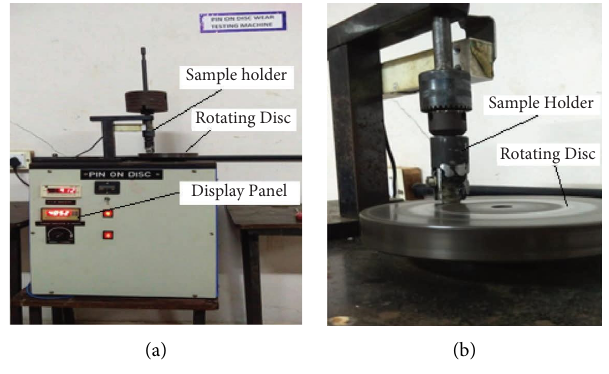
Figure 5: Pin-on-disc apparatus.